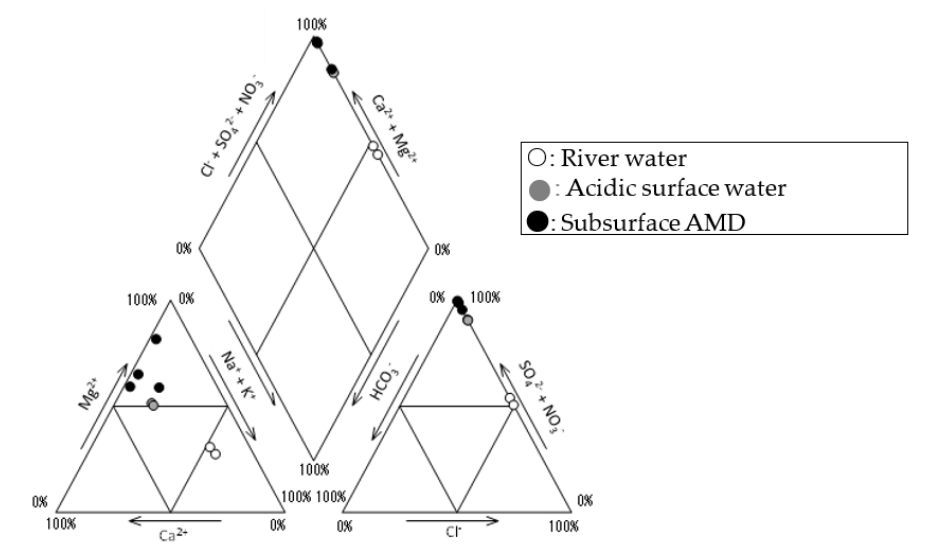
Figure 4. A Piper diagram showing the hydrochemical facies of the water samples.